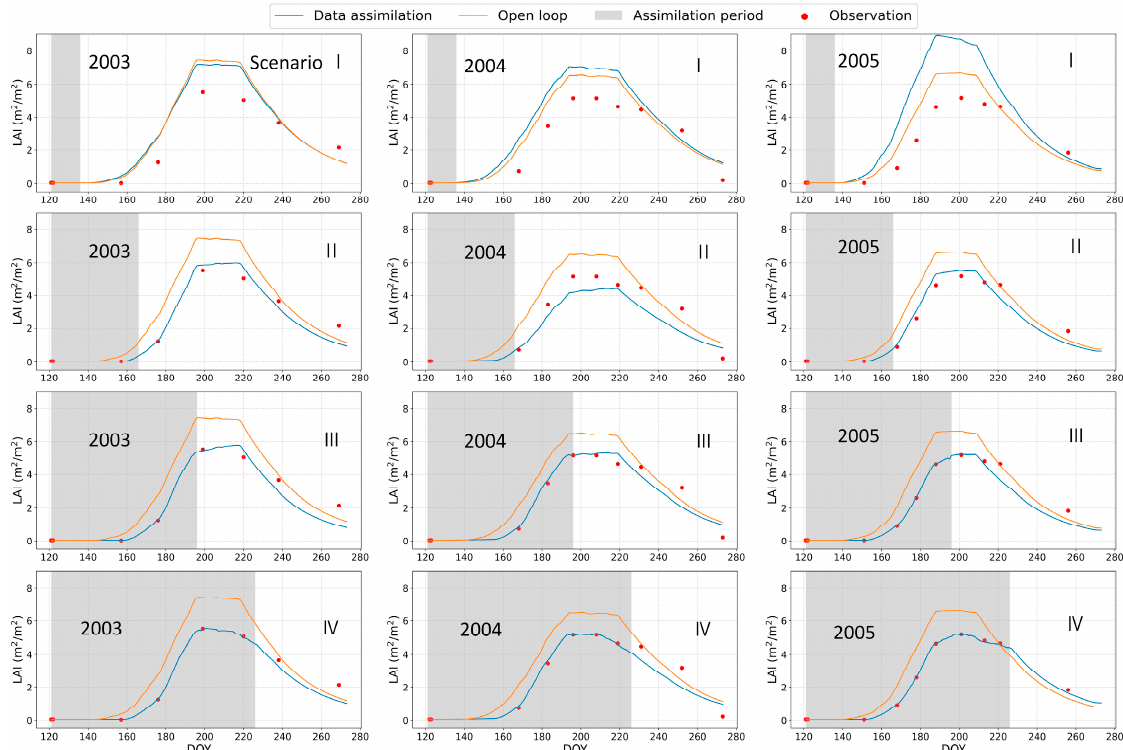
Figure 2. Leaf area index simulation and prediction from OL and MLDAS in 2003–2005. Results of four assimilation scenarios with different assimilation periods are given. Columns represent different assimilation scenarios in each year. The blue line in each subplot represents MLDAS simulation and prediction; the orange line in each subplot represents OL simulation; the red scatters represent LAI observations; and the shaded regions are the assimilation period, which starts from 1 May and lasts for 15 days, 45 days, 75 days, and 105 days for scenarios Ⅰ , II , Ⅲ , and Ⅳ , respectively.